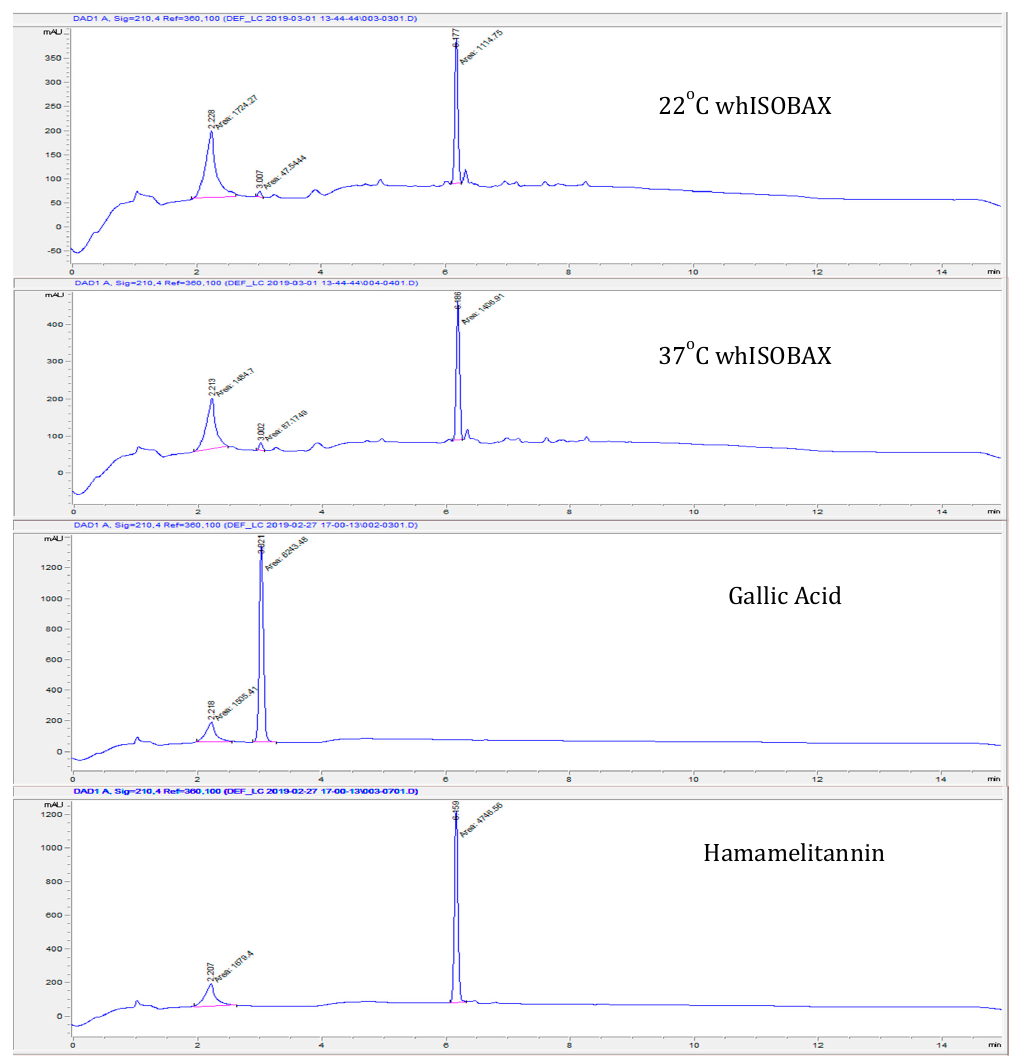
Figure 1. Stability of hamamelitannin (HAMA) and gallic acid in whISOBAX (WH); reverse phase HPLC analysis. WH (StaphOff Biotech Inc, Hopkinton, MA USA) that was incubated at 22 ◦ C or 37 ◦ C for 60 days, HAMA and gallic acid standards (Sigma-Aldrich, MO, USA) were applied to Durashell reverse phase C18 column in water containing 0.1% TFA. Bound material was eluted with an acetonitrile gradient. The HAMA and gallic acid content in WH were determined by comparing the retention time and absorbance spectrum with the